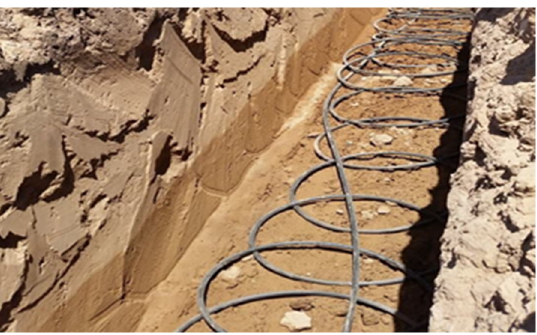
Figure 3. Slinky-type geothermal heat exchanger installation used in the GHP to assist the greenhouse.